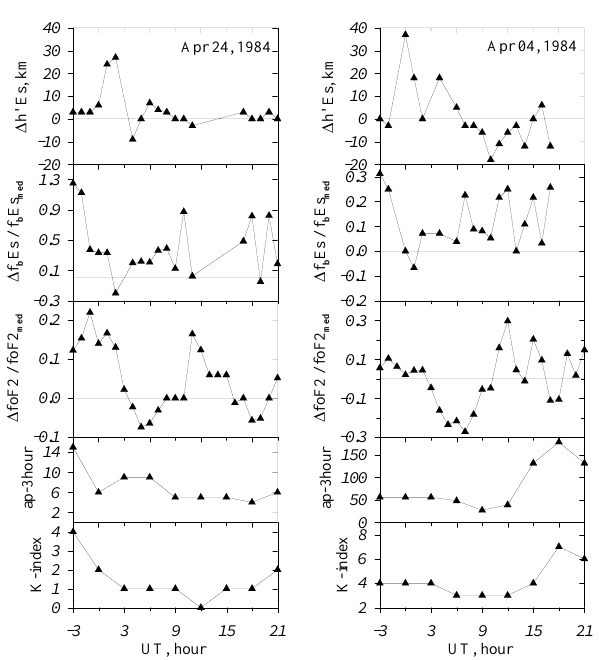
Fig. 2b. Same as Fig. 2a, but for the 26 September 1997 at 09:40UT (left panel) and 26 September 1997 at 00:33UT (right panel) earth- quakes.